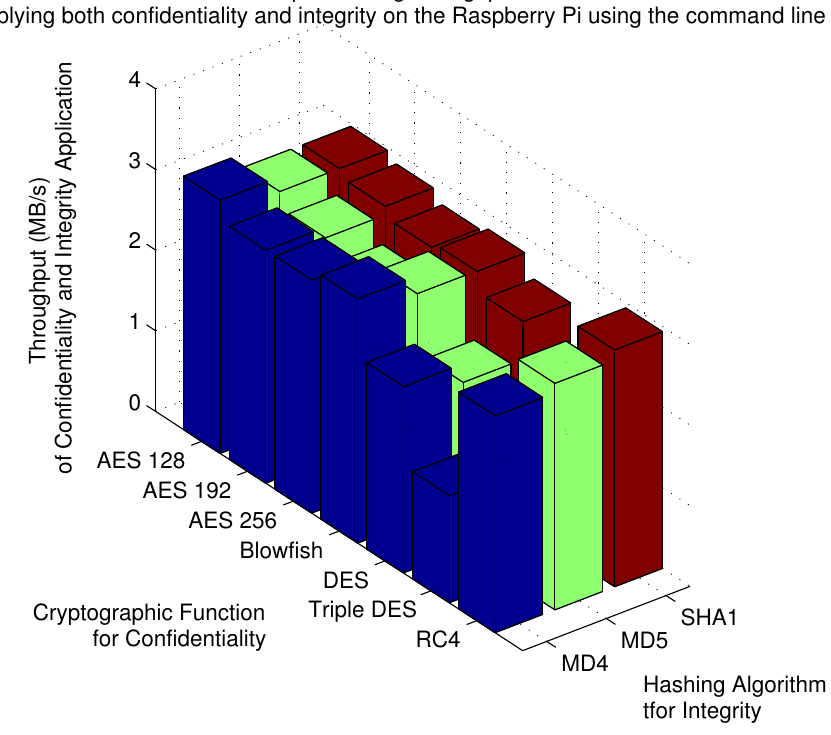
Figure 7. Throughput results when applying both confidentiality and integrity for command line